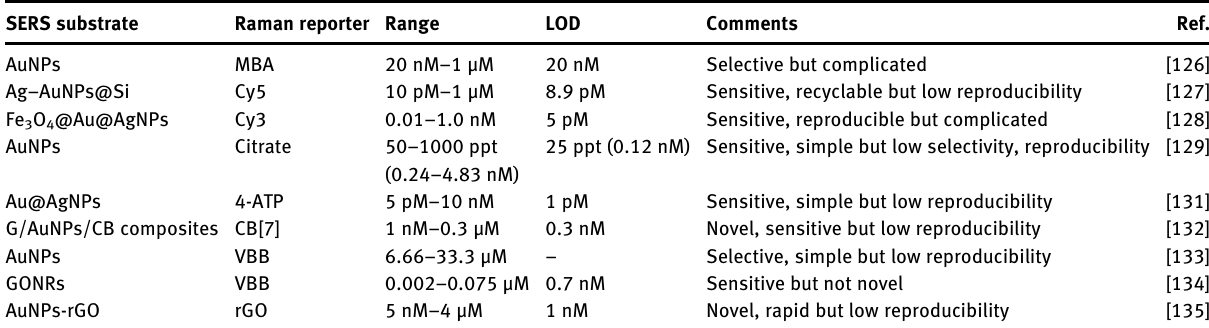
Table  : Various SERS sensors for Pb  + ions detection. SERS